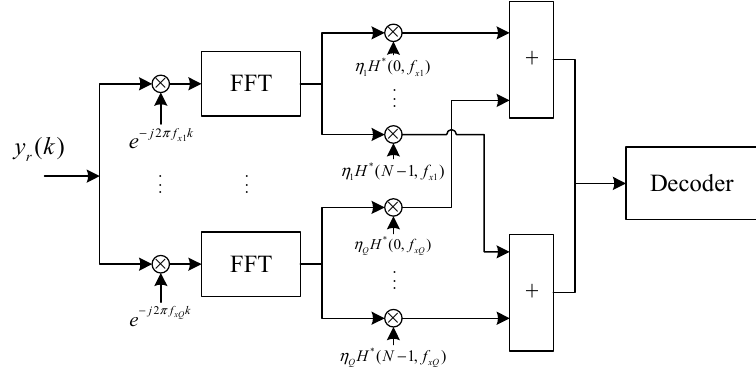
Figure 3. Structure of Doppler diversity reception.